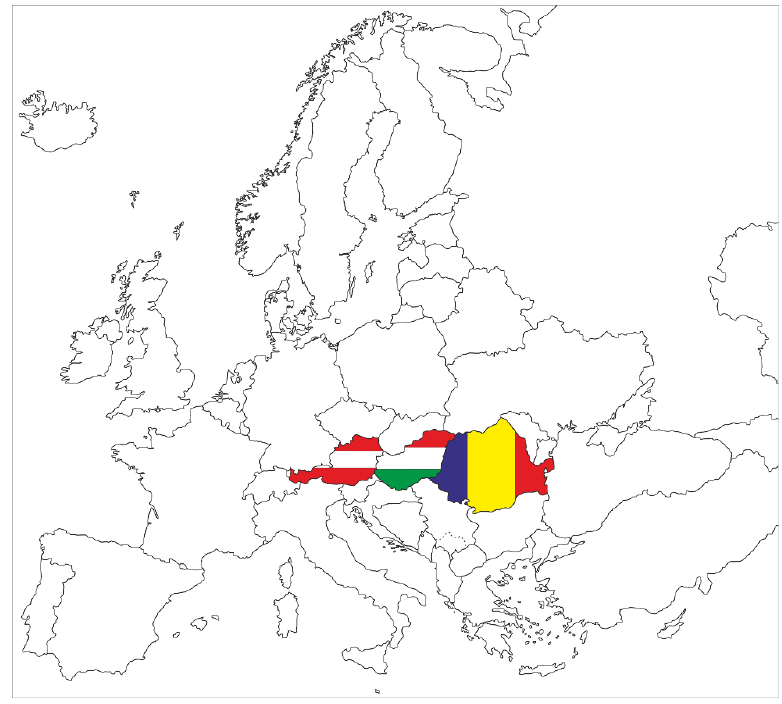
Figure 1. The three countries examined: Austria, Hungary and Romania.